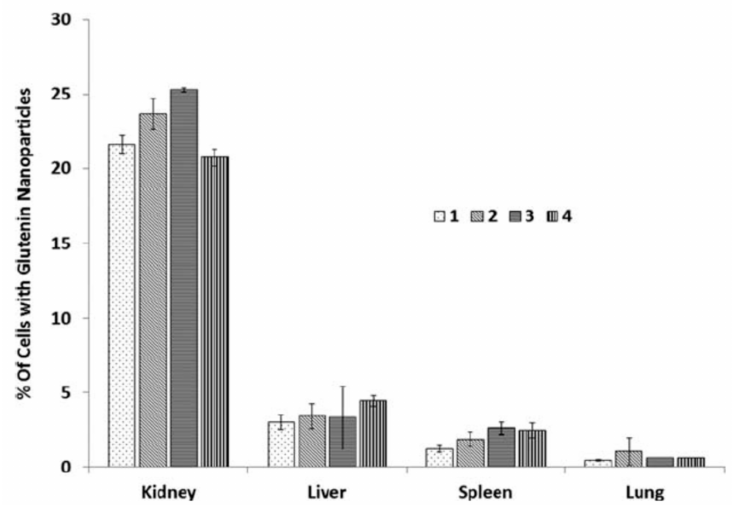
Figure 16. Biodistribution of wheat glutenin nanoparticles in different organs in mice. Reprinted with permission from ref. [98]. Copyright 2015 John Wiley and Sons.